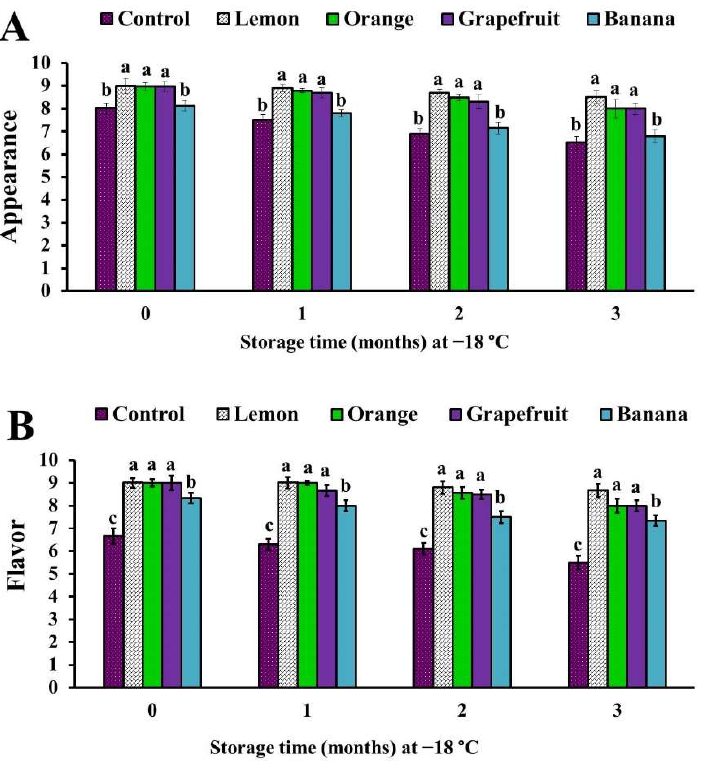
Figure 2. Appearance ( A ) and flavor ( B ) scores of chicken patties treated with different fruit peel powders. Columns marked by different letters indicate significant differences ( p < 0.05).